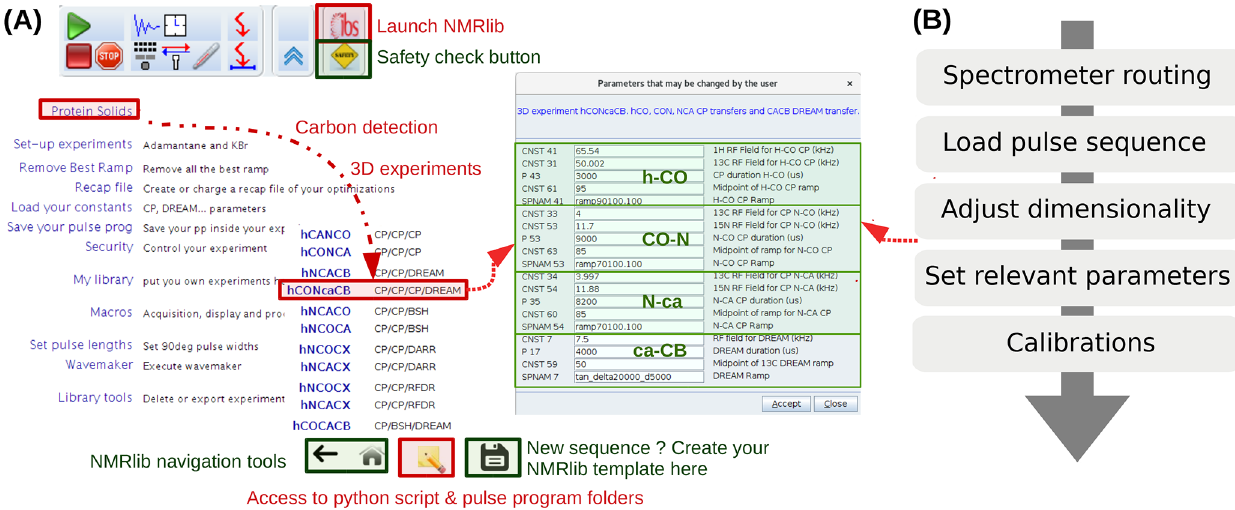
Figure 2. (a ) ssNMRlib windows and example workflow. An icon with the logo “ibs” in Topspin (top) launches the main GUI window (lower left). Here the navigation to a carbon-detected 3D hCONcaCB experiment is exemplified. After clicking the corresponding experiment button, a window with the relevant parameters opens, including reasonable propositions or (if available) pre-calibrated values of the most relevant acquisition parameters (right). The buttons on the bottom of the window allow navigation within the ssNMRlib file structures, access the underlying scripts in a file browser window, or save the current experiment as a template. (b ) Flow chart of the steps performed by the underlying ssNMRlib script when clicking an experiment button. The spectrometer routing files (one per detected nuclei) are a parameter set, obtained by saving ( wpar ) the parameter set of a high-dimensional experiment (typically 4D) with the correct